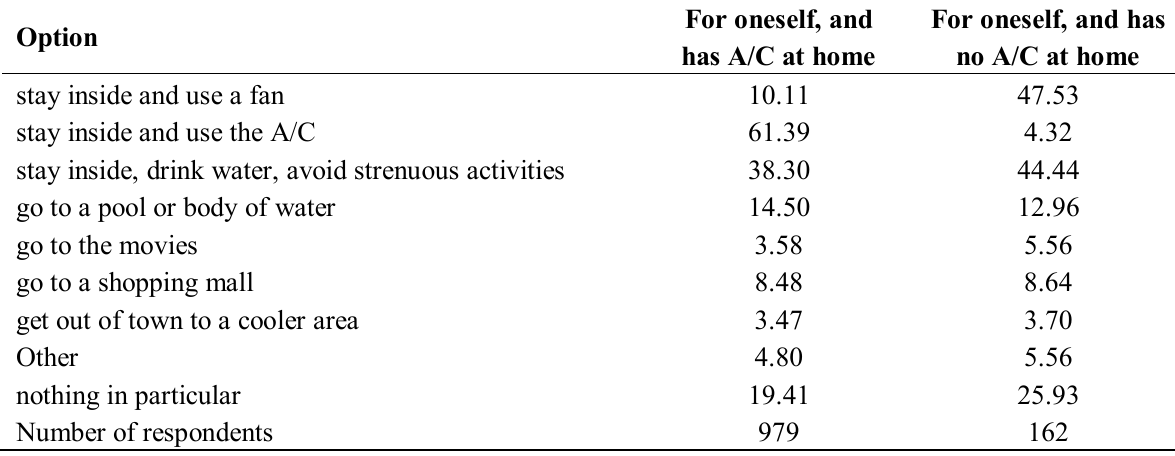
Table 16. Coping with a heat spell starting tomorrow by availability of air conditioning.